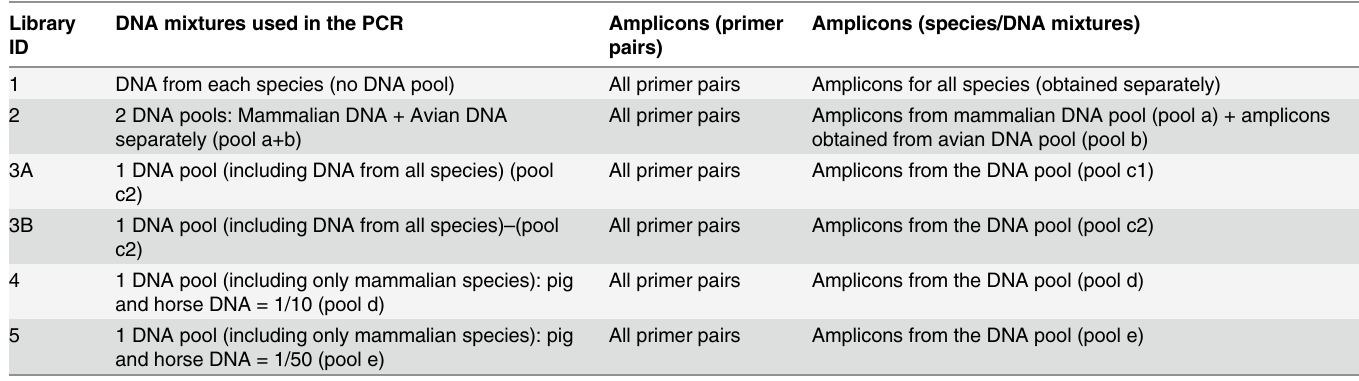
Table 3. Libraries prepared and sequenced with Ion Torrent PGM including amplicons obtained from different DNA mixtures. Library